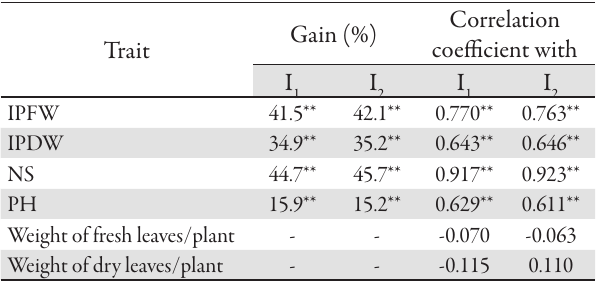
and I as compared to the 1 2